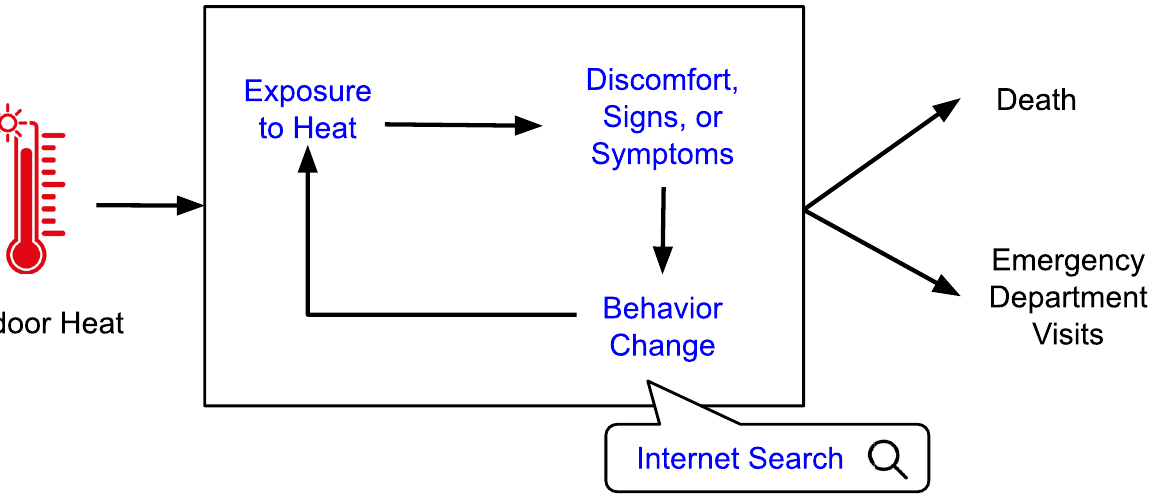
Figure 1. Conceptual framework highlighting the relationship between exposure to heat and health outcomes highlighting the additional, previously unmeasurable intermediate vulnerability that helps identify increased exposure, behavior change, and susceptibility measured using internet search